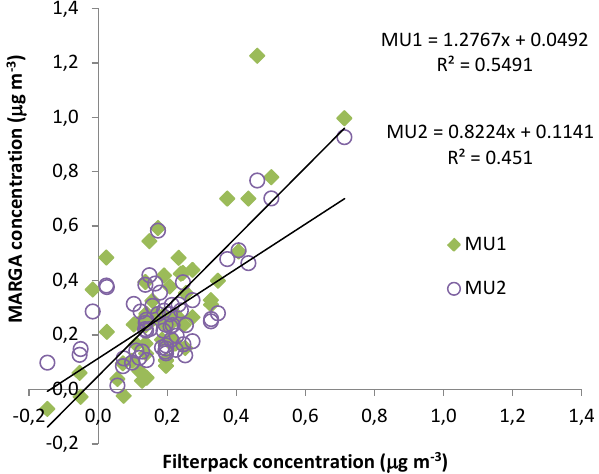
Figure 10. Regression analysis of estimated MARGA “fine” NO − Fig. 10. Regression analysis of estimated MARGA ‘fine’ NO 3- (total NO 3- minus NaNO 3 ) 2 (total NO − minus NaNO 3 ) concentrations against filter pack “fine” 3 concentrations against filter pack ‘fine’ NO 3- (total NO 3- minus NaNO 3 ) concentrations. 3 (total NO − minus NaNO 3 ) NO − 3 3